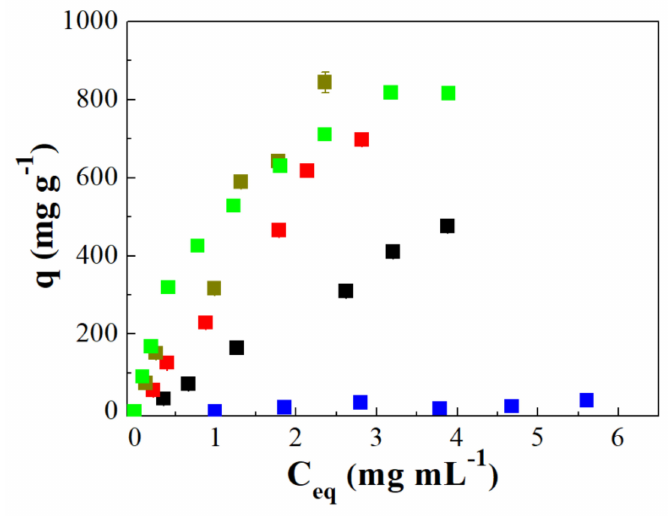
Figure 5. Batch adsorption experiments with individual protein solution containing IgG or HSA and solutions containing binary mixtures at three different cases. The conditions for all experiments were: 3.0 h of contact time, 3.0 mL of protein solution in contact with 15 mg of Si adsorbent. Case I ( ), case II ( ), case III ( ), 100% of IgG ( ) and 100% of HSA (